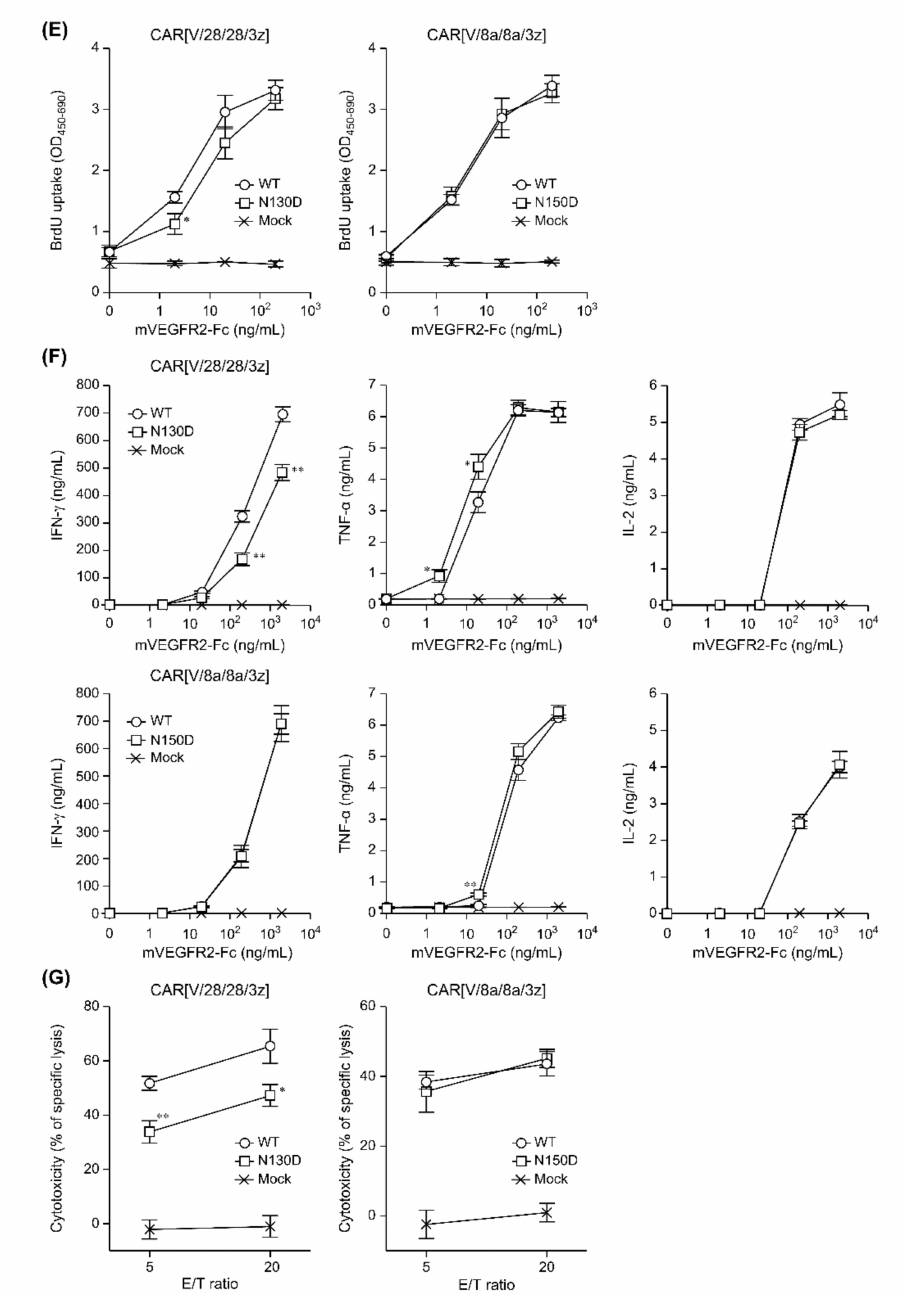
Figure 4. Influence on the expression and antigen-specific function of CAR[V/28/28/3z] or CAR[V/8a/8a/3z] after deletion of N-linked glycosylation in HD. ( A ) SDS-PAGE and Western blotting analysis showing the expression modality of four CAR variants in the whole CAR-T cell lysate on day 0. ( B ) The surface expression and antigen-binding ability were determined via FCM analysis on day 0. All cells were pre-gated with live cells, lymphocytes, and CD8 α + cells. ( C ) CAR mRNA expression was analysed via RT-qPCR and normalised relative to GAPDH mRNA as an endogenous control. ( D ) CAR expression on T cells was analysed via FCM. CAR expression level was calculated from the ratio of GMFI when stained with the anti-HA-tag mAb to GMFI when stained with the isotype control antibody. ( E ) Proliferation activity of HD-modified CAR-T cells following mVEGFR2 stimulation. ( F ) Cytokine production ability of the above cells following mVEGFR2 stimu- lation. ( G ) Cytotoxic activity of the above cells four days after Rv transduction against mVEGFR2 + EL4 cells. The data were obtained from three independent tests. Statistical analysis was performed using Welch’s t -test (* p < 0.05 and ** p < 0.01 versus